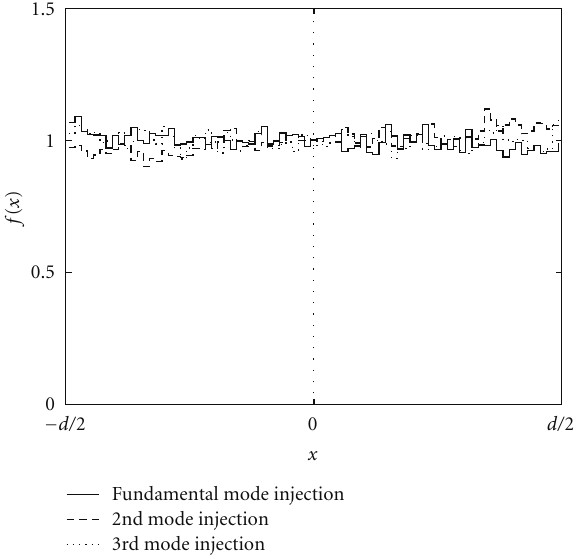
Figure 5: Spatial distributions f ( x ) of the transmitted electrons for the incidence of each three propagating